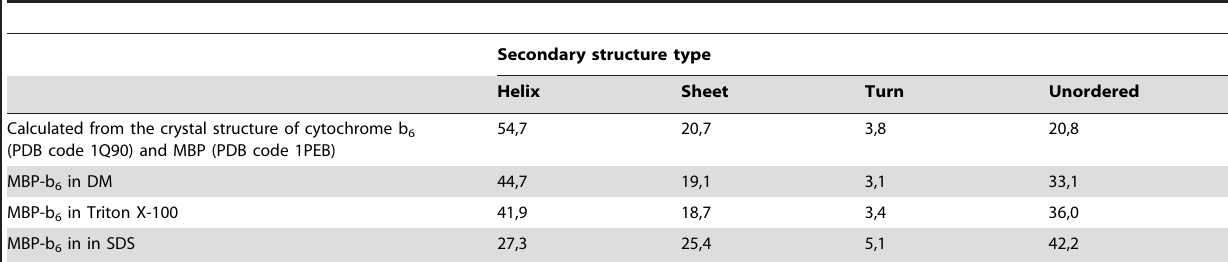
Table 4. Predicted per cent secondary structure content of the MBP-b 6 in detergent solutions (Triton X-100, DM or SDS) from CD analysis.